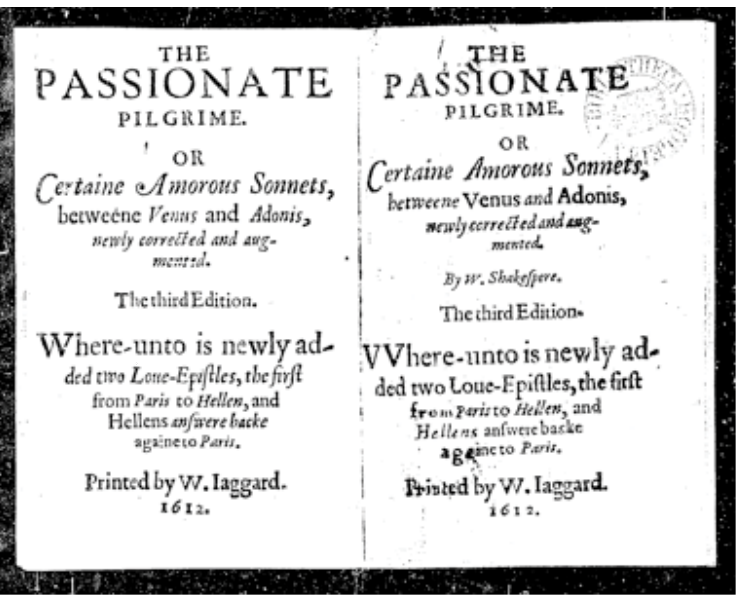
Fig. 1 – Th e Passionate Pilgrime (1612), STC 22343, Arch G g.1, Titlepages on sig. A1v and